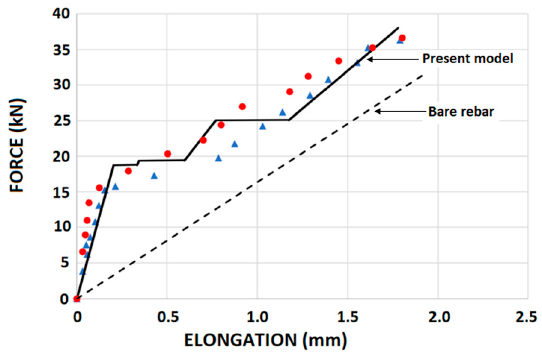
Figure 8. Comparison of Rizkalla et al. tests [40] with model analysis.